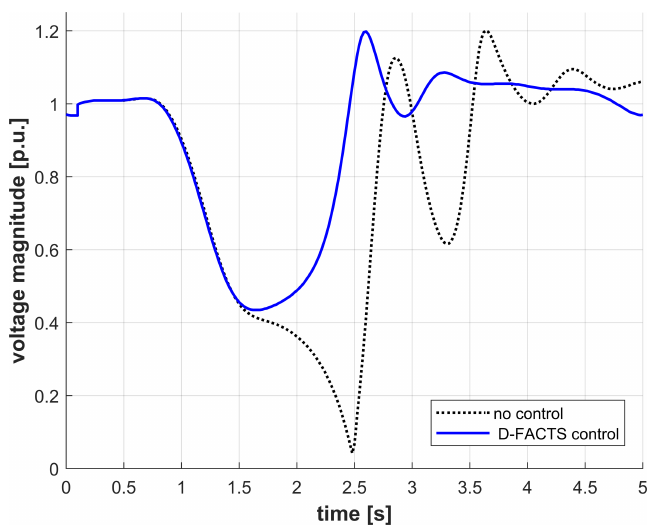
Figure 13. Voltage magnitude trajectory at the 400-kV Rizziconi busbar (Calabria).